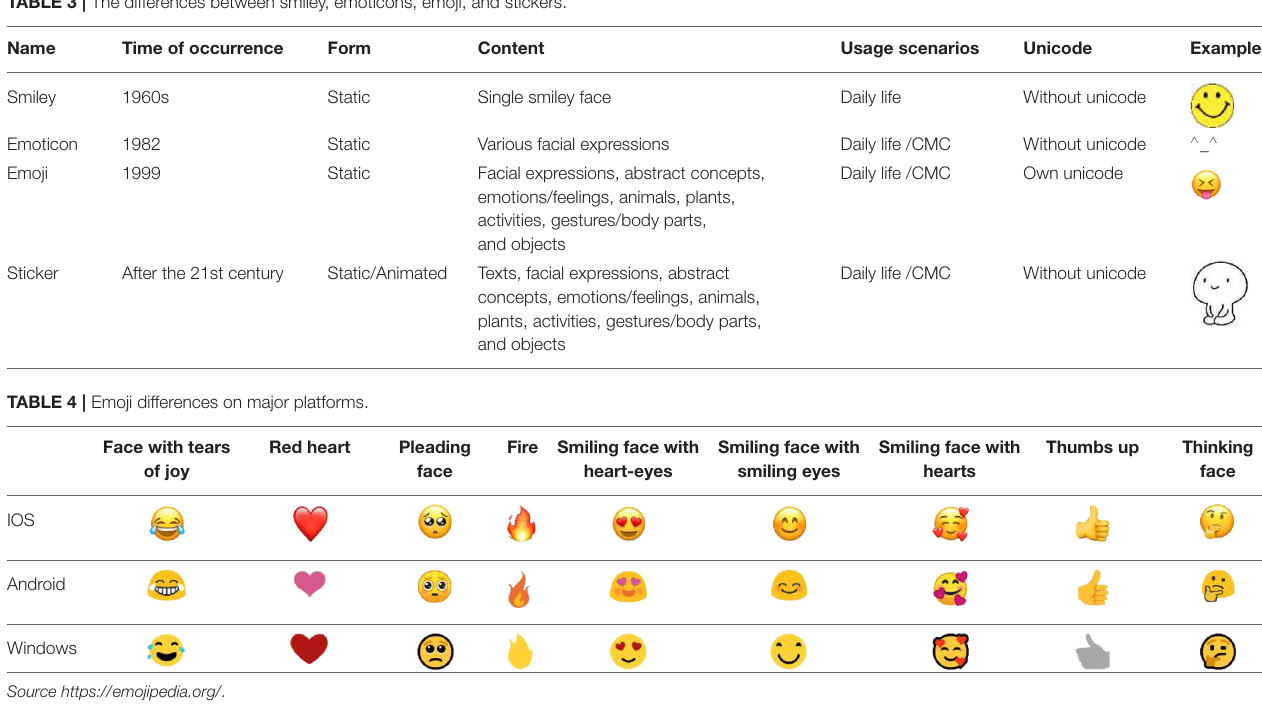
TABLE 3 | The differences between smiley, emoticons, emoji, and stickers.